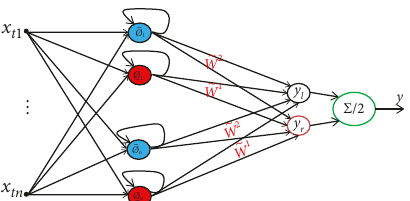
Figure 1: The structure of the proposed type-2 fuzzy system.